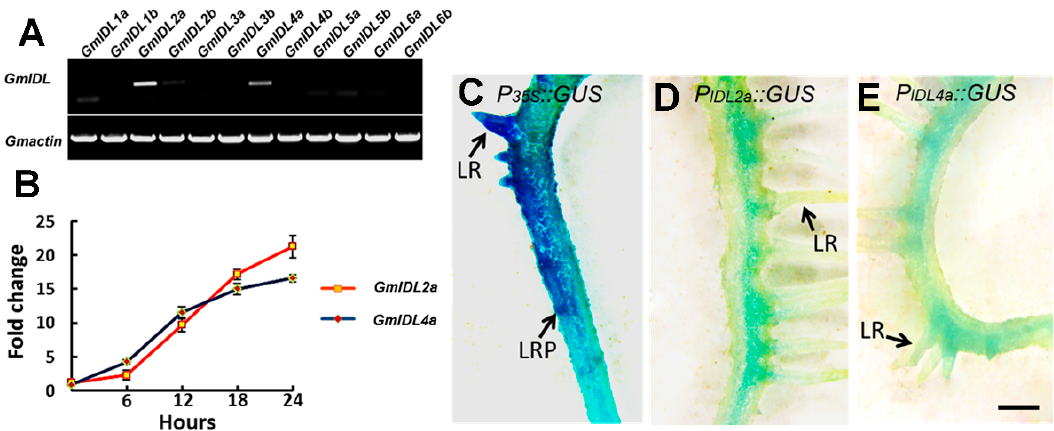
Figure 2. The expression of GmIDL genes in soybean roots. ( A ) RT-PCR analysis of GmIDL s in soybean roots; ( B ) relative expression of GmIDL2a and GmIDL4a under auxin treatments; ( C – E ) GUS histochemical staining assay of P 35S ::GUS; ( C ) P IDL2a ::GUS and P IDL4a ::GUS hairy roots under normal